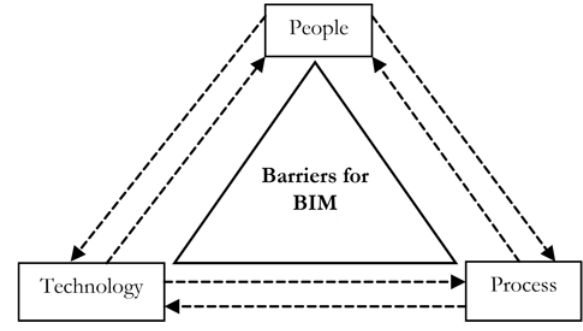
Figure 1 Dynamic interrelationships between people, process and technology aspects of BIM education